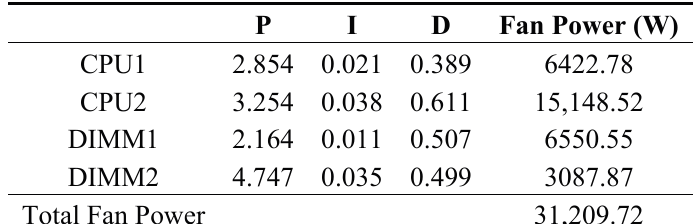
Table 3. PID gains without overshoot and fan power consumption.